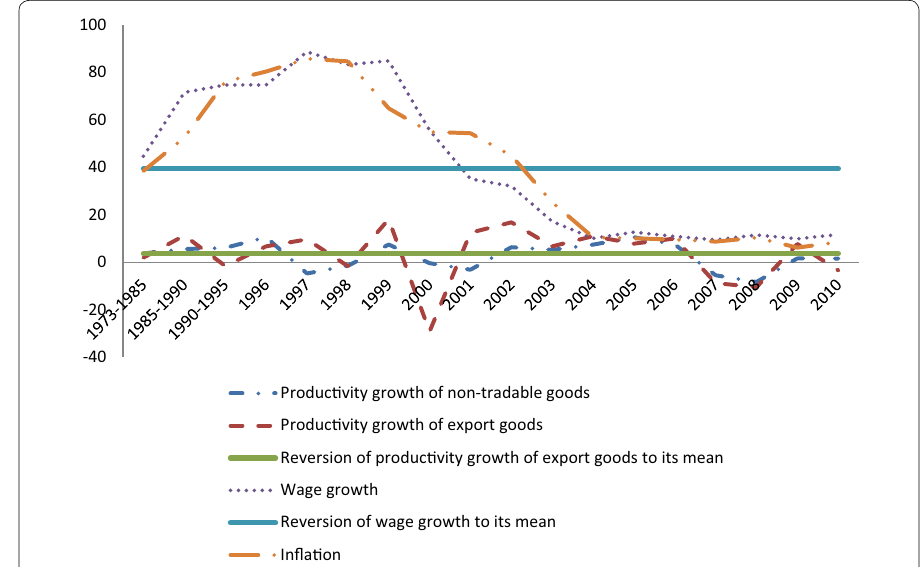
Fig. 1 Productivity growth rates, wage growth and inflation (annual, unit: %) Source : The tables for 1973, 1985 and 1990 were derived from TurkStat and are aggregated to nine main industries in order to use ILO employment data; the other tables were derived from WIOD in order to calculate productivity growth rates. Inflation was derived from the World Bank (inflation, consumer price).The calculation is based on Ünal (2016b, 2018). See “Appendix” for calculation methods (Price levels described in equations can be calculated to find mark-up rate and negligible import cost. For export price, export at current prices (national currency) is divided by export at constant prices (national currency), and for the non-tradable price, non-tradable goods at current prices is divided by non-tradable goods at constant prices. Domestic demand import. Domestic demand represents non-tradable goods. Data were derived from the United Nations data,